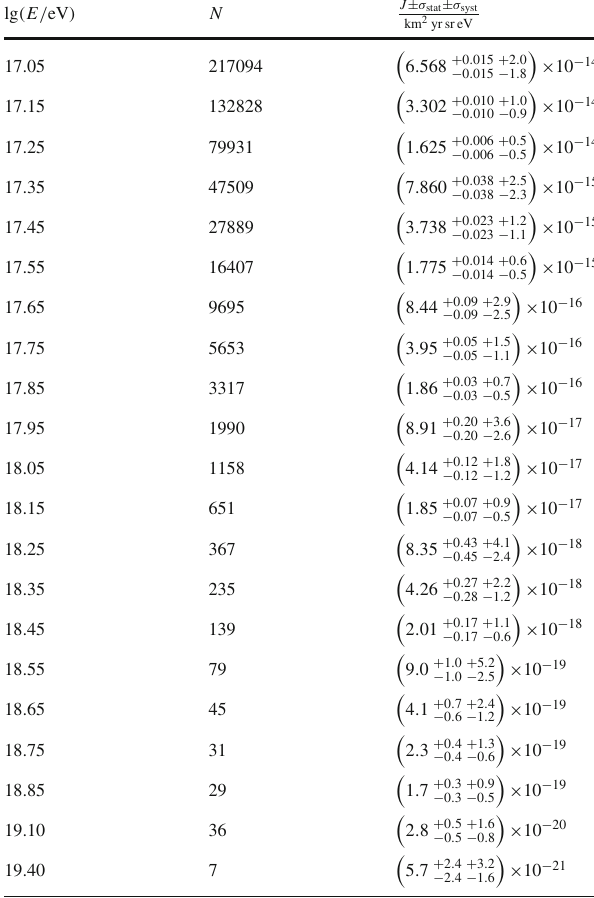
Fig. 20 The scaling factor that has been applied to the raw spectrum to produce the unfolded spectrum (see Eq. (12)) and the statistical uncer- tainty Table 8 SD-750 spectrum data. The correlations between systematic uncertainties are provided in the Supplementary material lg ( E / eV